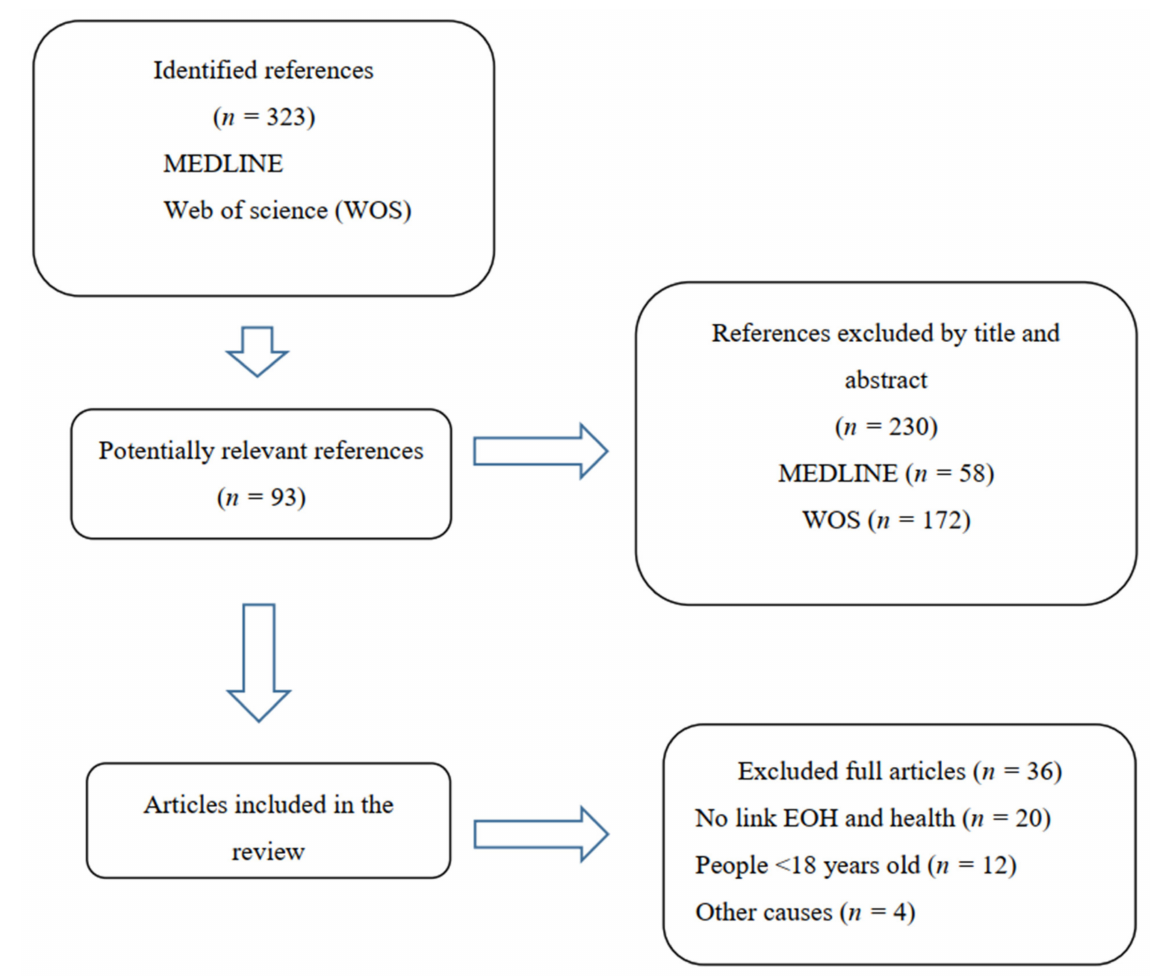
Figure 1. Flow diagram illustrating the screening process for eligible